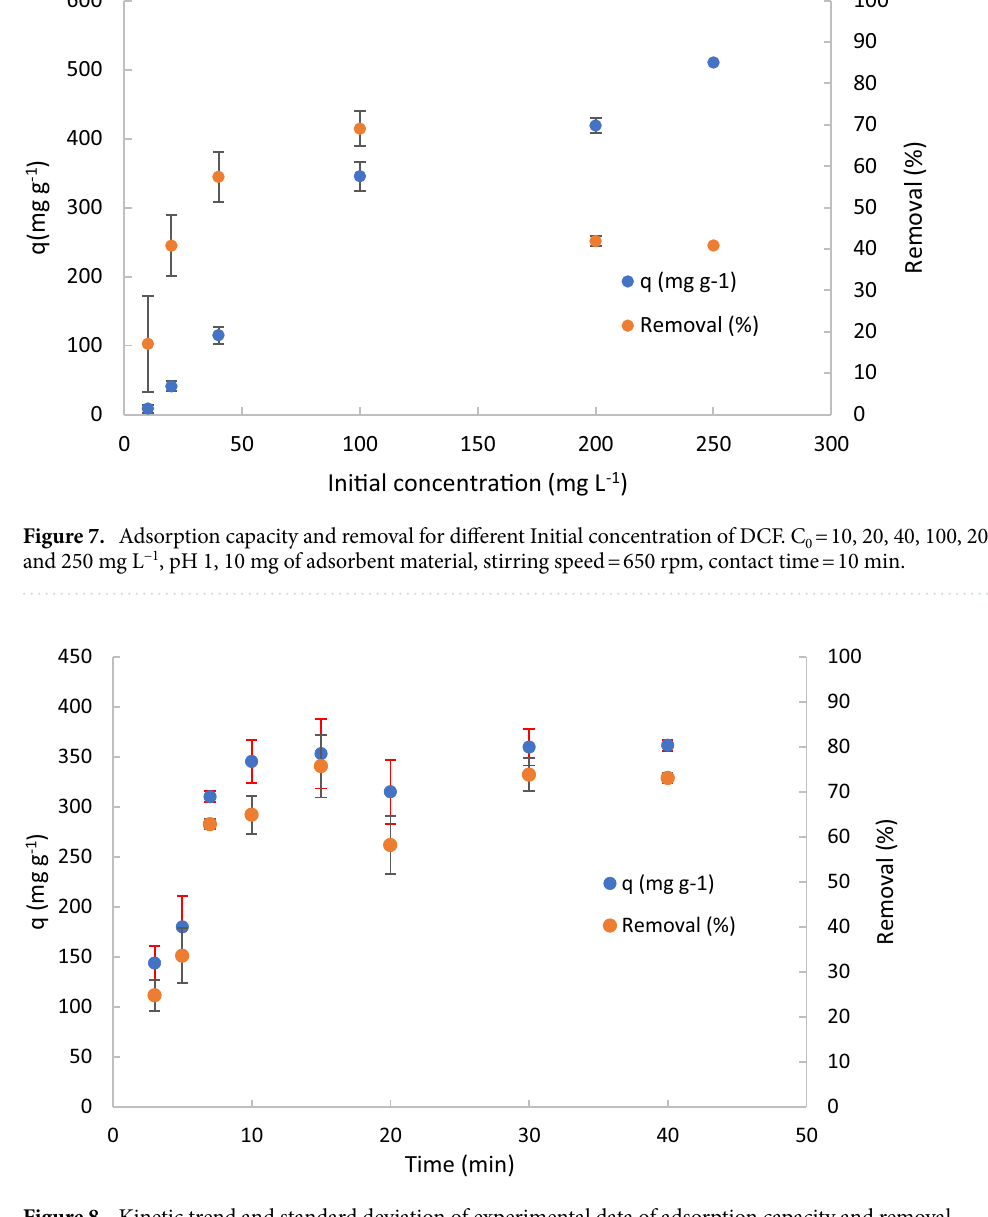
Figure 8. Kinetic trend and standard deviation of experimental data of adsorption capacity and removal with contact time. C o = 100 mg L −1 , Solution volume = 50 mL, pH 1, mass of adsorbent = 10 mg, stirring speed = 650 rpm. Some values of standard deviation are lower than surface area of